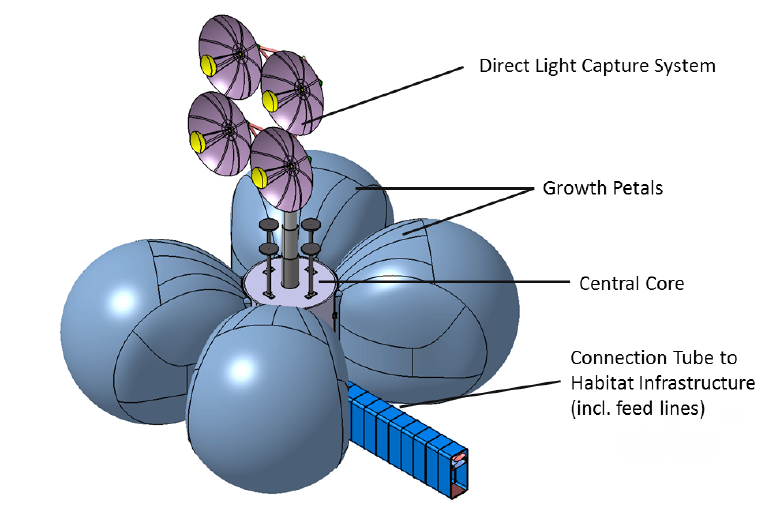
Figure 1: Main elements of the GHM